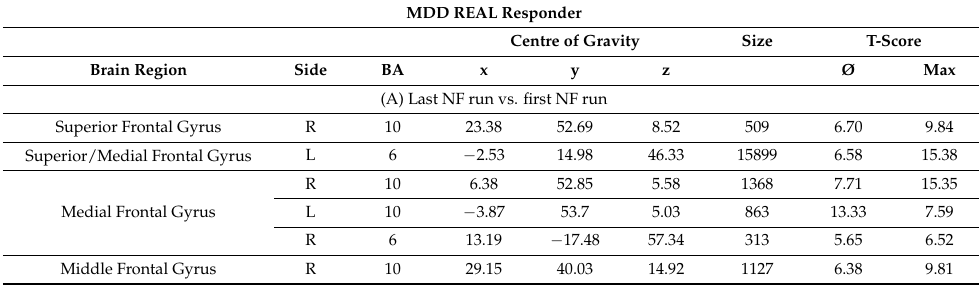
Table 8. Comparison of hemodynamic responses between the first and the last NF run in the MDD REAL Responder group (negative emotion-associated pictures minus neutral pictures; clusters of >30 voxels, p (Bonf) < 0.05, T-score: 8 to −